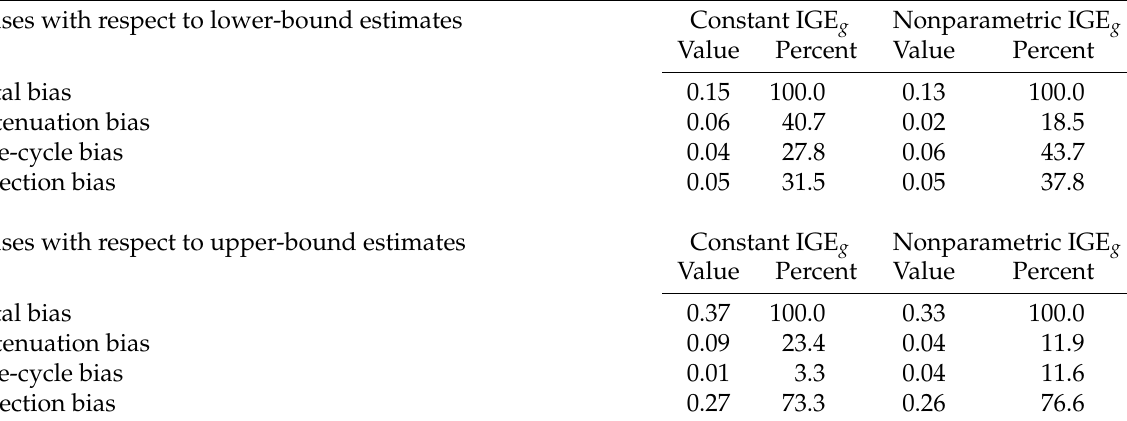
Table 6: Model-specific Shapley decompositions of total bias in IGE g estimation. Biases with respect to lower-bound